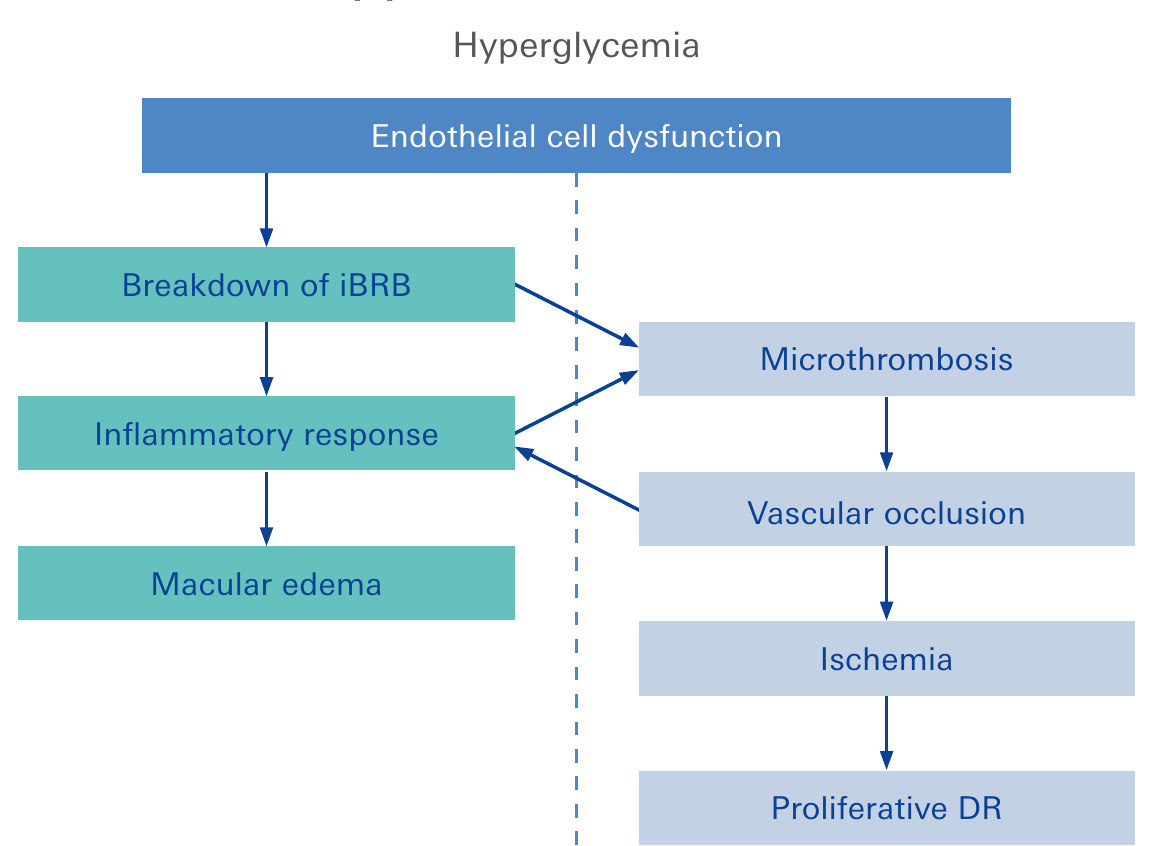
Figure 4. Ocular complications of diabetes: Diabetic retinopathy is a diabetes mellitus-associated retinal condition. The increasing damage to small blood vessels (microangiopathy) causes damage to the retina that is initially unnoticed. However, two complications threaten vision: diabetic macular edema and proliferative diabetic retinopathy. Macular edema is characterized through accumulation of fluid in the macula and seriously distorts vision. The occurrence of retinal/vitreal neovascularization is characteristic of proliferative diabetic retinopathy, the late form of DR, which will lead to blindness if left